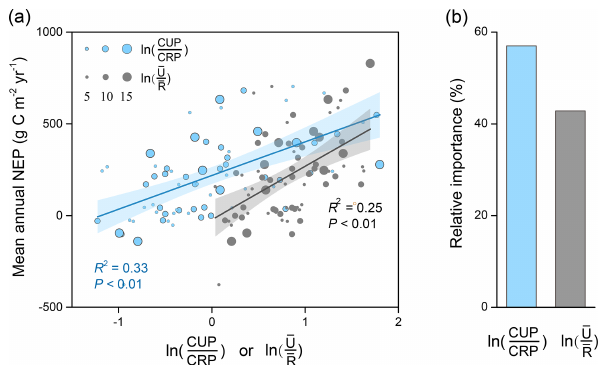
Figure 4. The relative contributions of the local indicators in ex- plaining the spatial patterns of mean annual NEP. (a) The lin- ( R 2 = 0 . 33, ear regression between mean annual NEP with CUP CRP P < 0 . 01) and U ( R 2 = 0 . 25, P < 0 . 01) across sites. (b) The rela- R tive contributions of each indicator to the spatial variation in mean annual NEP. The number of years at each site is indicated with the size of the